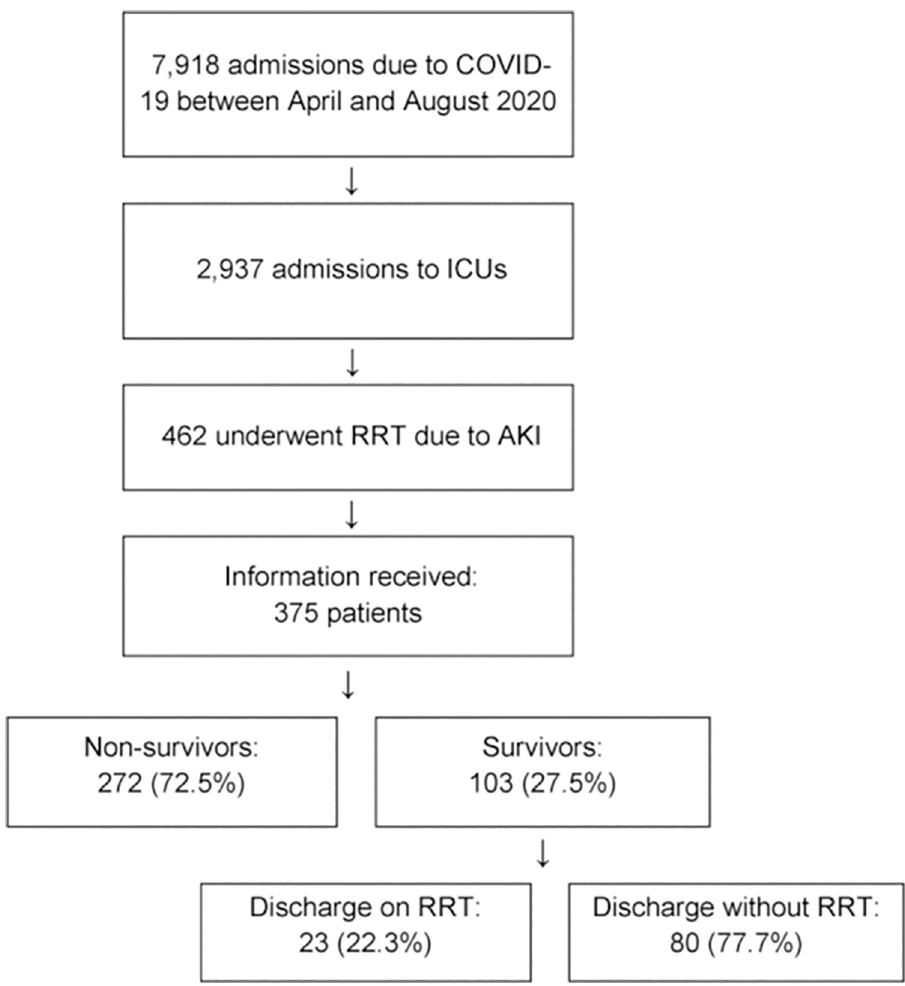
Fig 1. Patient inclusion flowchart and outcomes. COVID-19, a disease caused by the new coronavirus; ICUs: Intensive care units; RRT, renal replacement therapy; AKI, acute kidney injury.